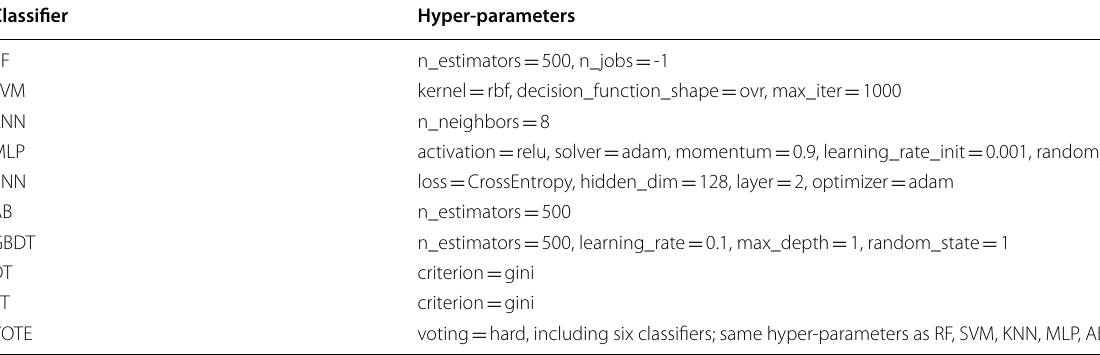
Table 9 The hyper-parameters of